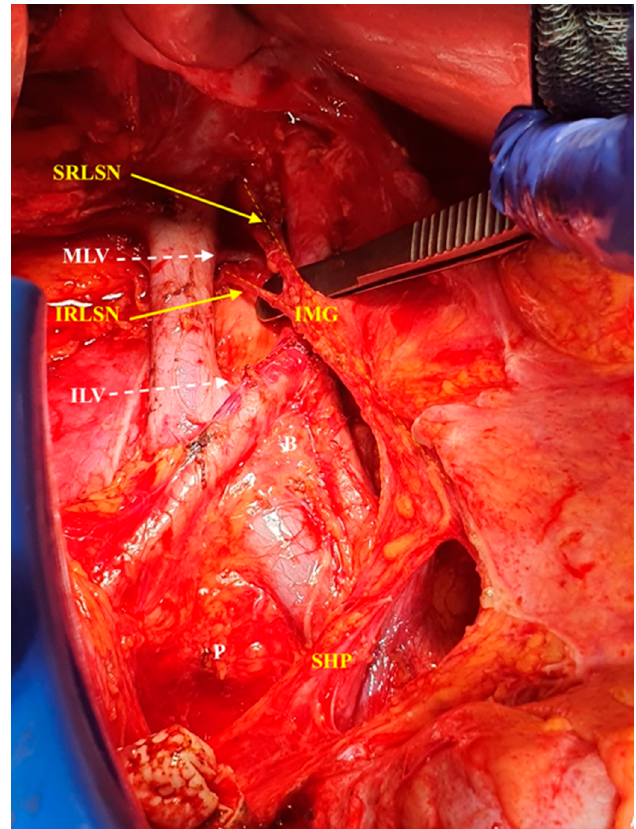
Figure 1. The right cord of aortic plexus. SRLSN, superior right lumbar splanchnic nerve; MLV, middle lumbar vein; IRLSN, inferior right lumbar splanchnic nerve; ILV, inferior lumbar vein; IMG, inferior mesenteric ganglion; SHP, superior hypogastric plexus.